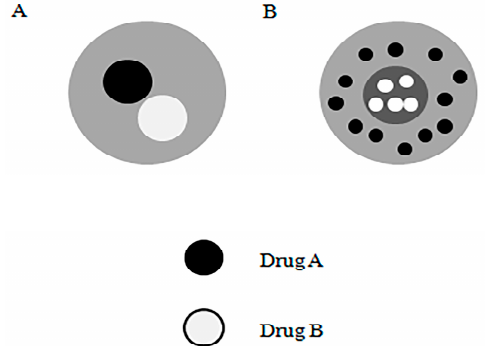
Figure 7. A brief comparison of the structure of ( A ) multi-compartment microparticles, and ( B ) multilayered microparticles loaded with multiple drugs at the same time (Adapted from [84]).